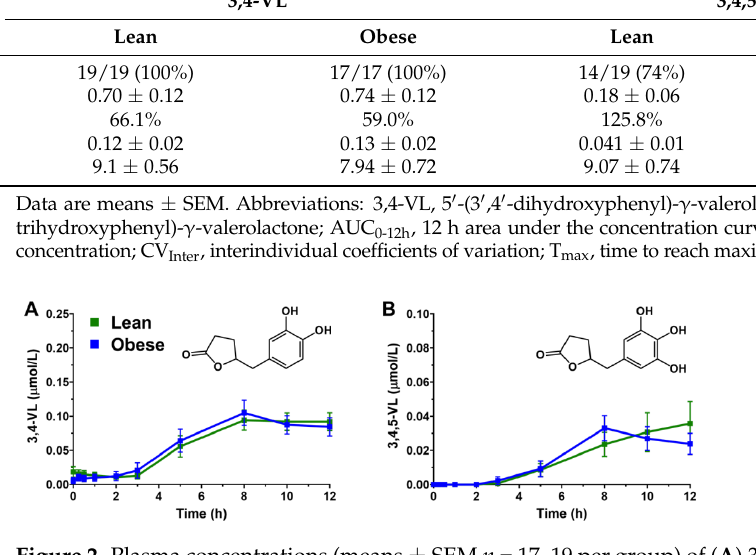
Figure 2. Plasma concentrations (means ± SEM n = 17–19 per group) of ( A ) 3,4-VL and ( B ) 3,4,5-VL in lean and obese persons after oral ingestion of a GTE-rich confection containing 290 mg EGCG, 87 mg EGC, 39 mg EC, and 28 mg ECG. Abbreviations: 3,4-VL, 5′ - (3′,4′ -dihydroxyphenyl)- γ -valerolac- tone; 3,4,5- VL, 5′ - (3′,4′,5′ -trihydroxyphenyl)- γ -valerolactone; EC, epicatechin; ECG, epicatechin gal- late; EGC, epigallocatechin; EGCG, epigallocatechin gallate.